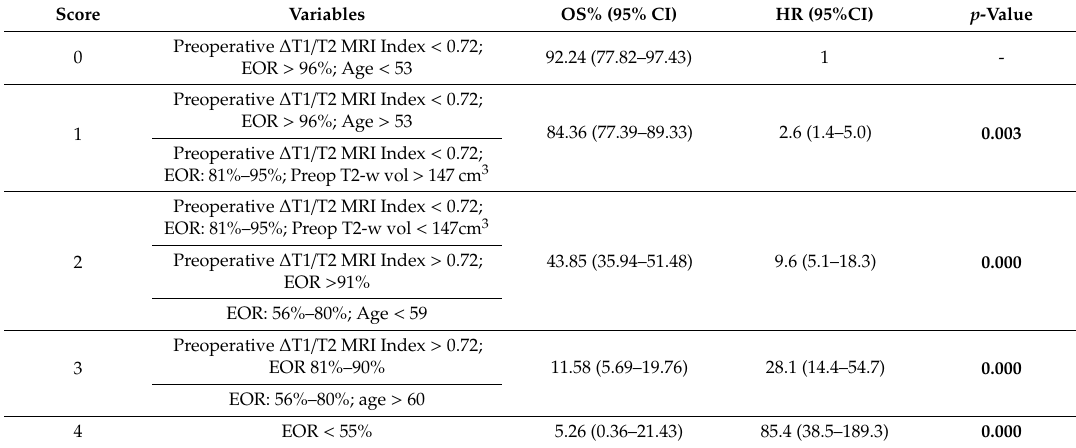
Table 3. One-year estimated overall survival and hazard ratios for each score with relative 95% confidence intervals. A score (GBM-associated prognostic score, GAPS) from 0 to 4 was then assigned to the 10 terminal nodes thus defined based on the relative hazard ratio (RHR).